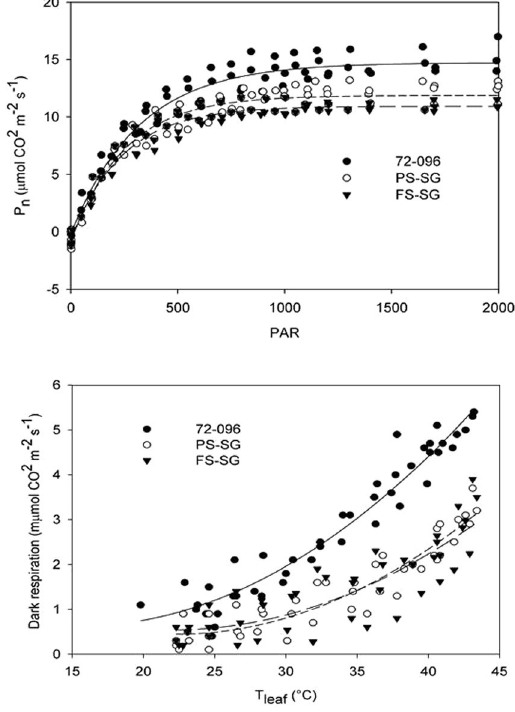
Figure 2. ( a ) Leaf net photosynthesis (P n ) vs. light intensity (PAR) of fully expanded leaves of Accession 72-096 (y = − 0.1908 + 14.9208 * (1 − e ( − 0.0032x) ), R 2 = 0.94, P < 0.001), FS-SG (y = − 0.6954 + 11.6205 * (1 − e ( − 0.0042x) ), R 2 = 0.95, P < 0.001) and PS-SG (y = − 0.8528 + 12.7258 * (1 − e ( − 0.0040x) ), R 2 = 0.94 P < 0.001); ( b ) Leaf dark respiration (R D ) vs. leaf temperature (T leaf ) of fully expanded leaves of 72-096 (y = 2.1066 − 0.1924x + 0.0063x 2 R 2 = 0.94 P < 0.001), FS-SG (y = 3.0714 − 0.2300x + 0.0052x 2 R 2 = 0.87, P < 0.001) and PS-SG (y = 3.4158 − 0.2674x + 0.0060x 2 R 2 = 0.73; P < 0.001). Measurements were carried out between 20 and 24 June 2016 on 5 mature leaves per